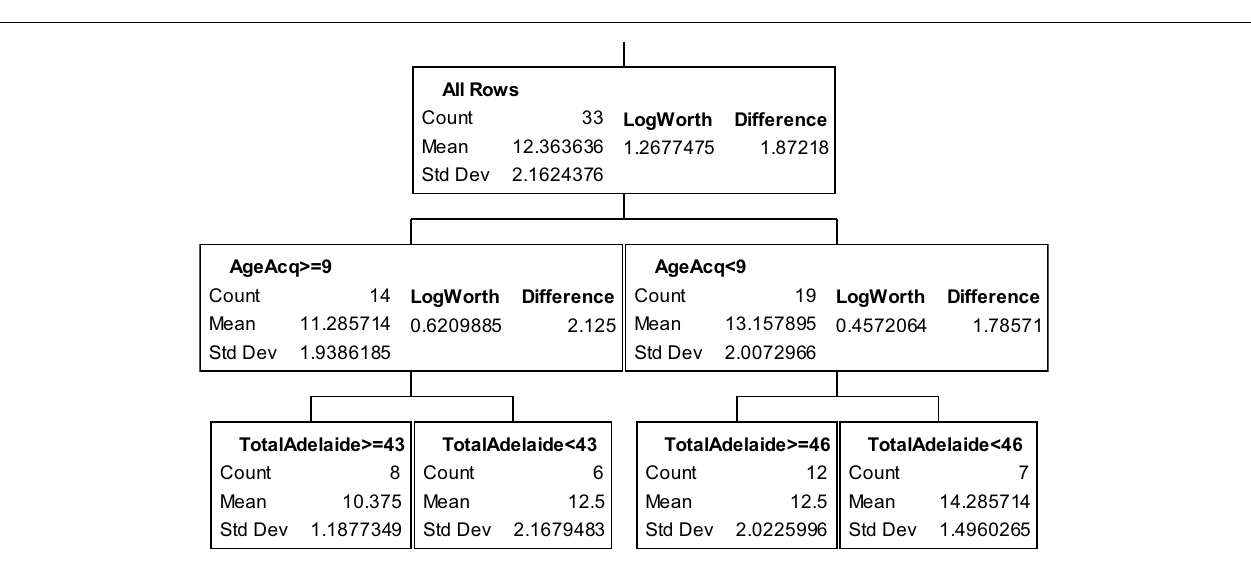
FIGURE 2 | Partition analysis for letter-number sequencing for